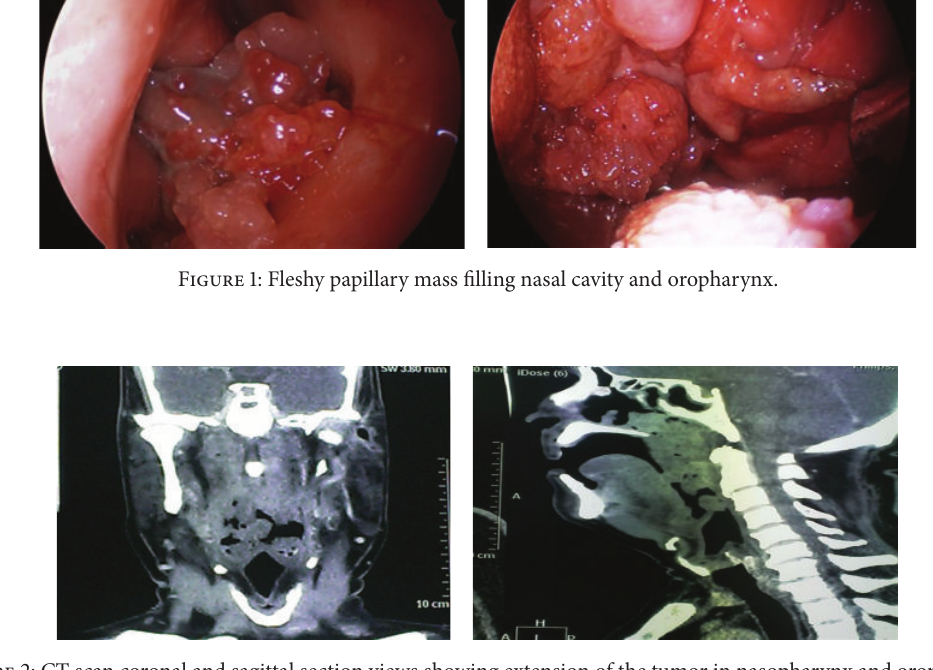
Figure 2: CT scan coronal and sagittal section views showing extension of the tumor in nasopharynx and